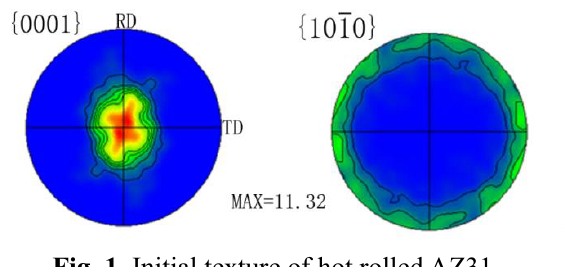
Fig. 1. Initial texture of hot rolled